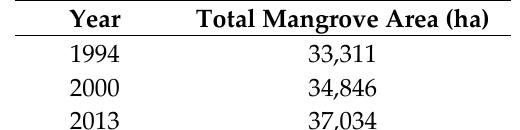
Table 3. Mangrove extent within the Zambezi River Delta mapped in 1994, 2000 and 2013 using Landsat data.